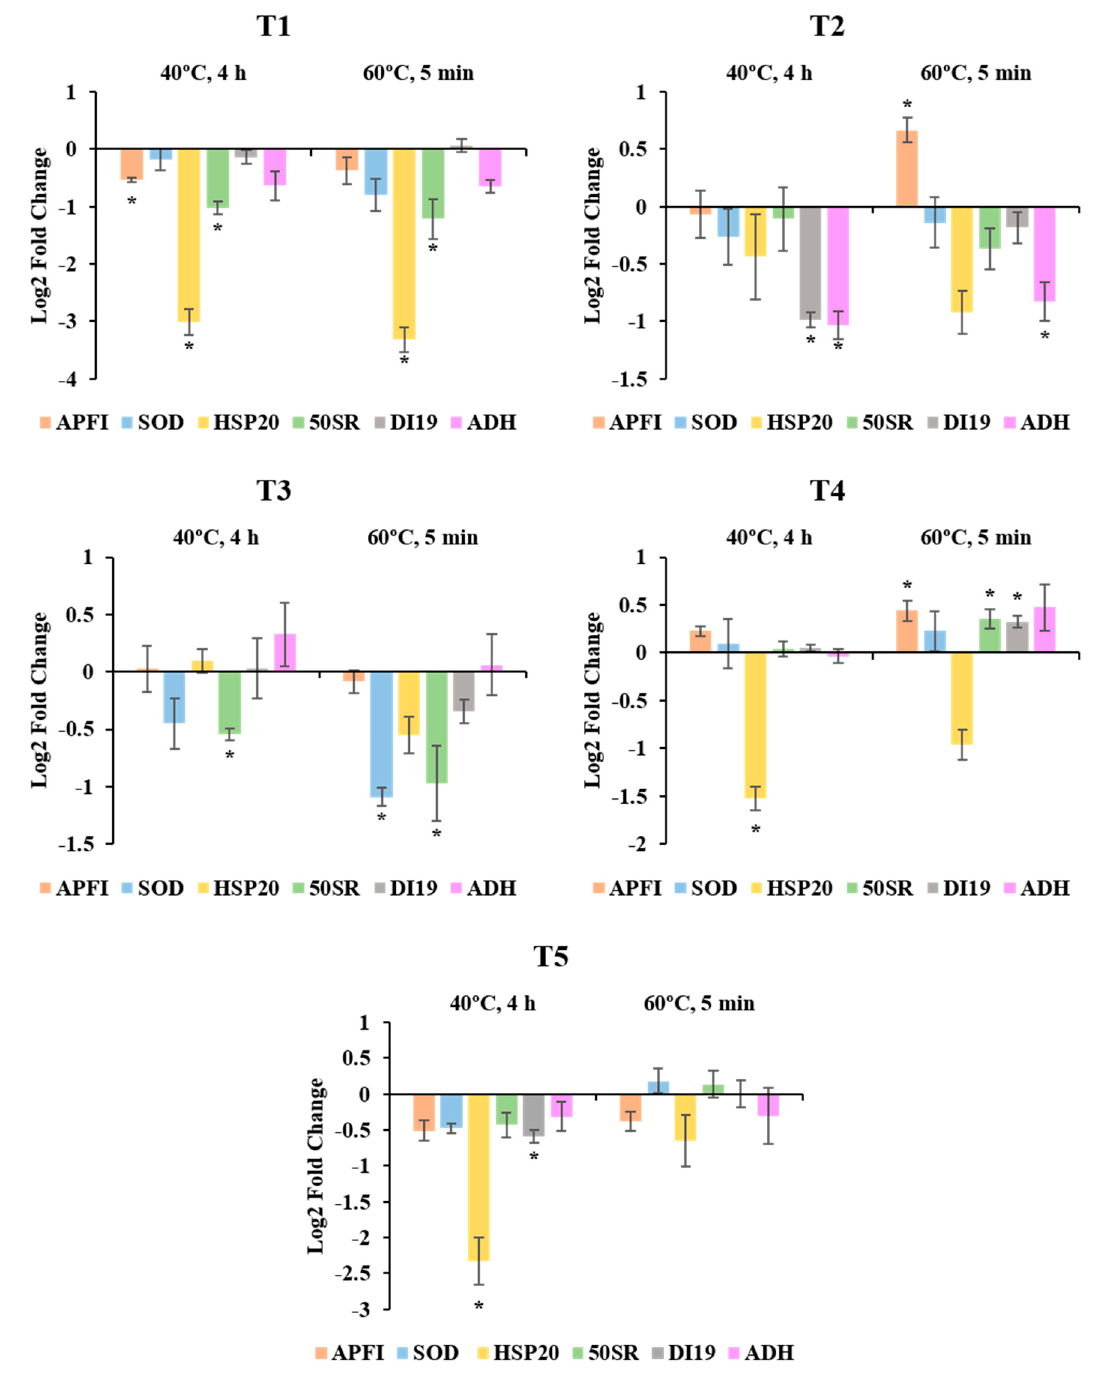
Figure 1. Fold-relative gene expression of six stress-related genes ( APFI , SOD , HSP20 , 50SR , DI19 and ADH ) along the different stages of Pinus radiata somatic embryogenesis (T1, T2, T3, T4 and T5) between samples originating from different temperature conditions during induction (23 °C, 8 weeks; 40 °C, 4 h; 60 °C, 5 min). Data are presented as mean values ± SE. * Denotes significant differences at p < 0.05 among high temperature treatments with respect to the control temperature of 23 °C.